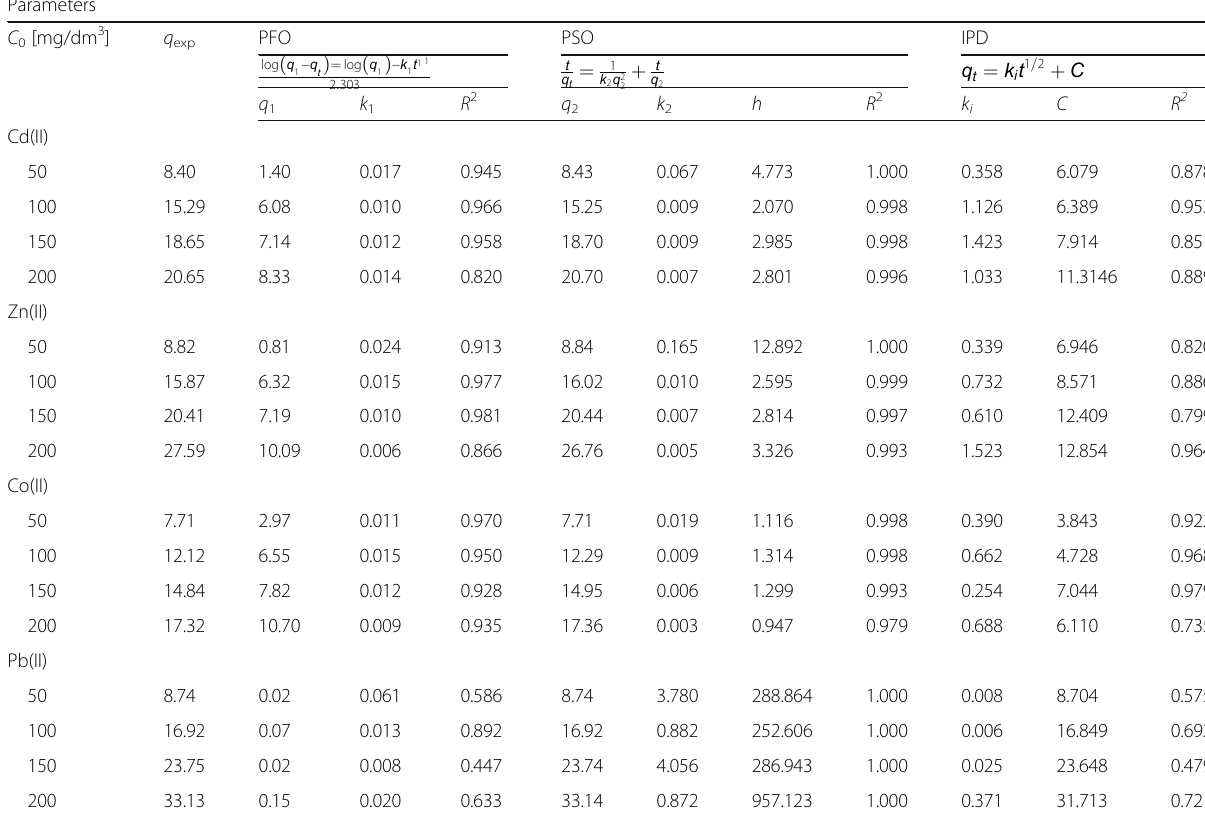
Table 1 Parameters for various adsorption kinetic models for Cd(II), Co(II), Zn(II) and Pb(II) sorption on MBC1